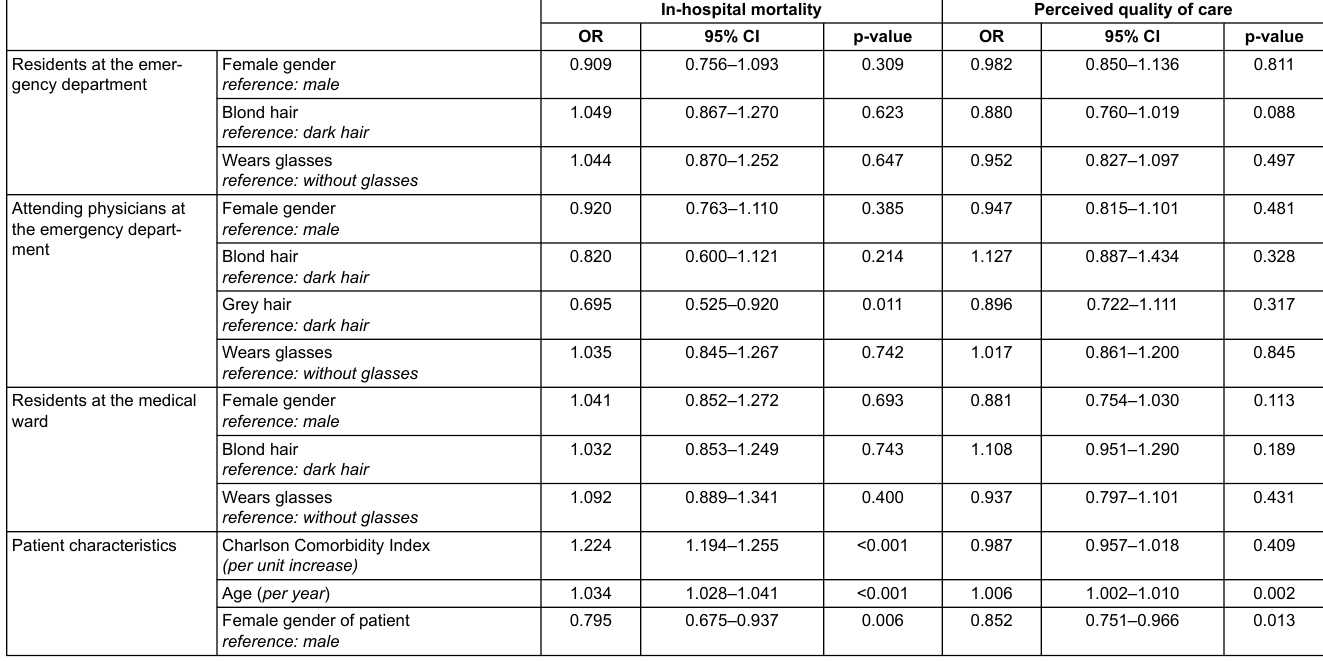
Table 3: Results of multivariable regression analysis regarding the relationship between characteristics of the treating physician and in-hospital mortality and perceived quality of